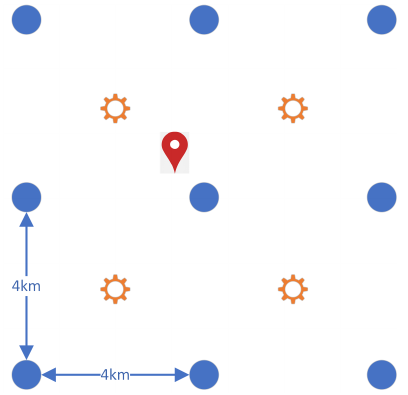
Figure 2. Weather forecast grid. Circles indicate wind-field nodes, suns indicate climate-field nodes, pin indicates wind farm